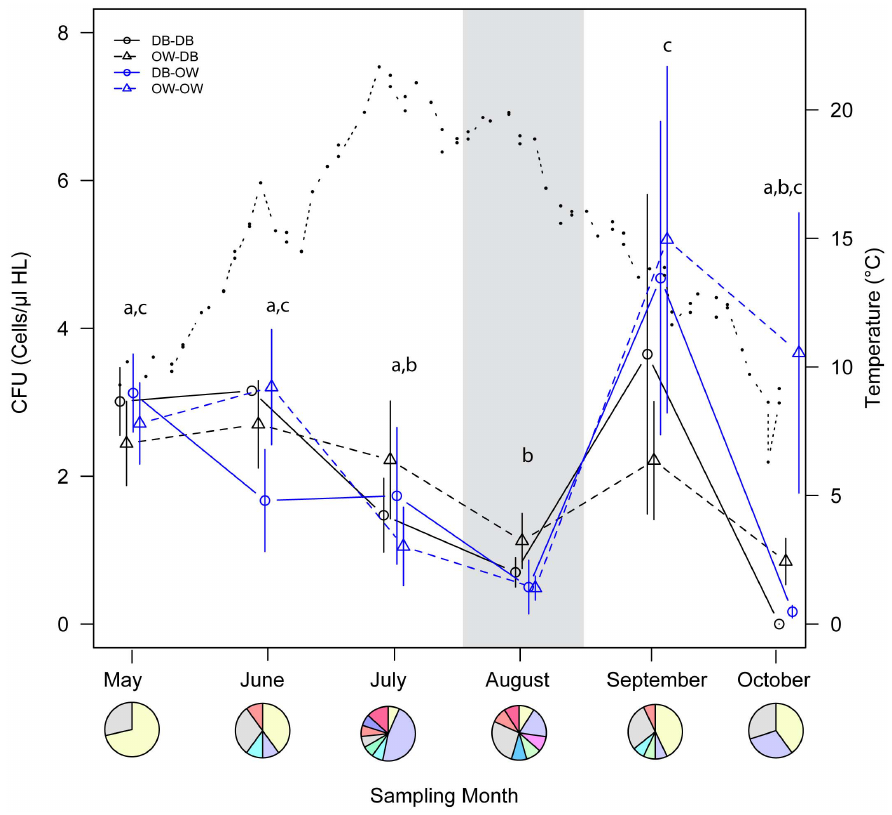
Figure 1. Temporal variation in the amount of Vibrio bacteria in oyster hemolymph (HL). Quantification of total Vibrio spp. (open circles and triangles) isolated from oyster hemolymph stemming from the four transplant groups (origin_site), i.e. DB_DB, DB_OW, OW_DB, OW_OW. Blue lines represent oysters assayed in site OW and black lines represent oysters assayed in site DB. Solid lines show oyster origin DB, while dashed lines show oyster origin OW. Water temperature is shown on the secondary y-axis (full circles, dotted line). The area shaded in grey marks the spawning period. Different letters indicate significant differences according to Tukey HSD post hoc test. Pi charts show relative proportion of Vibrio isolates by phylogenetic association based on 99% similarity by BLASTN analysis in each sampling month. Color codes correspond to those in Figure 2.